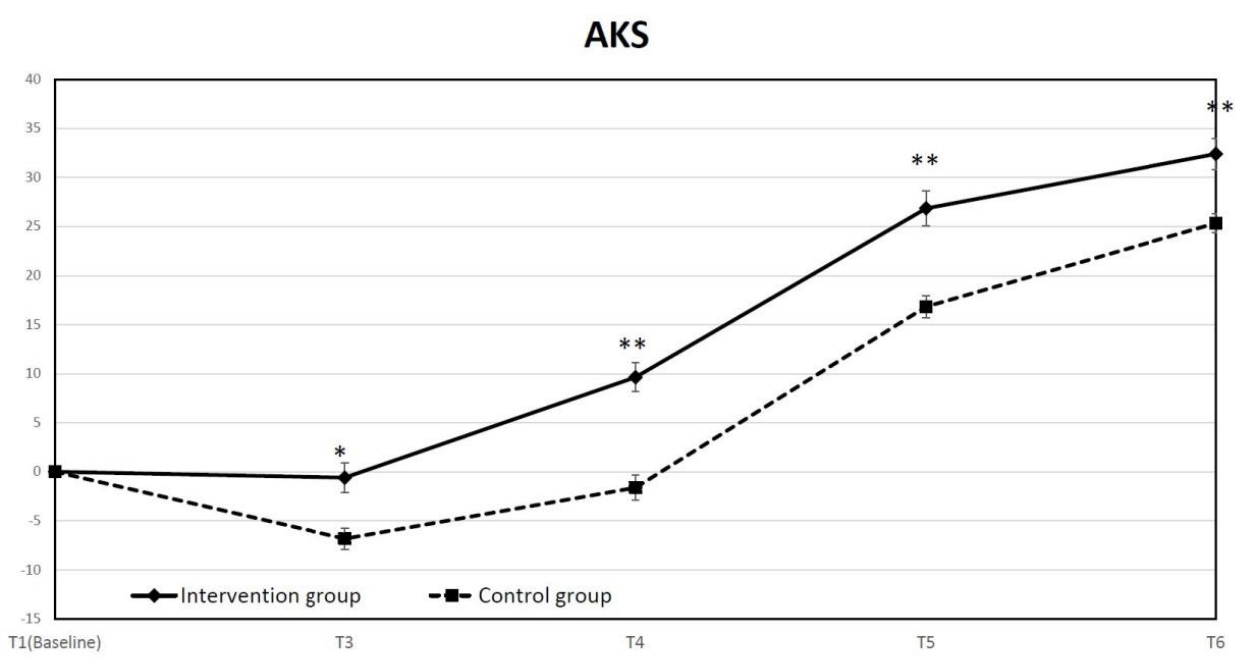
Figure 4. Time course of mean change in American Knee Society Score (AKS) from baseline to each checked time point. (* p < 0.05, ** p < 0.01).